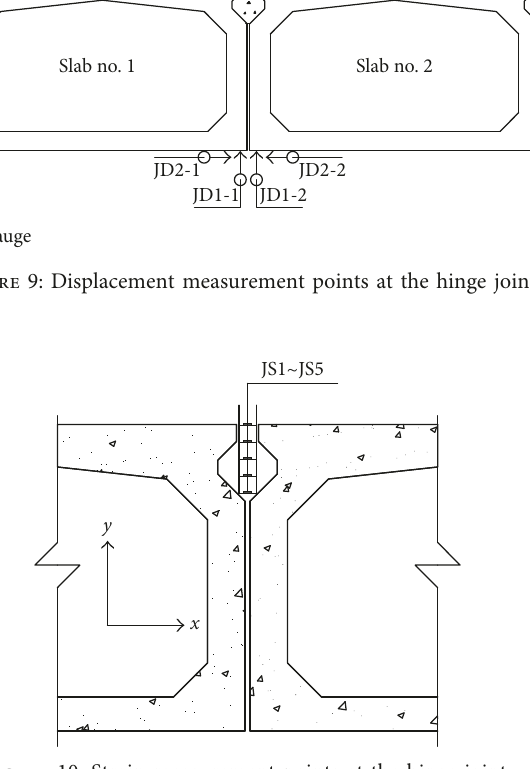
Figure 10: Strain measurement points at the hinge joint.